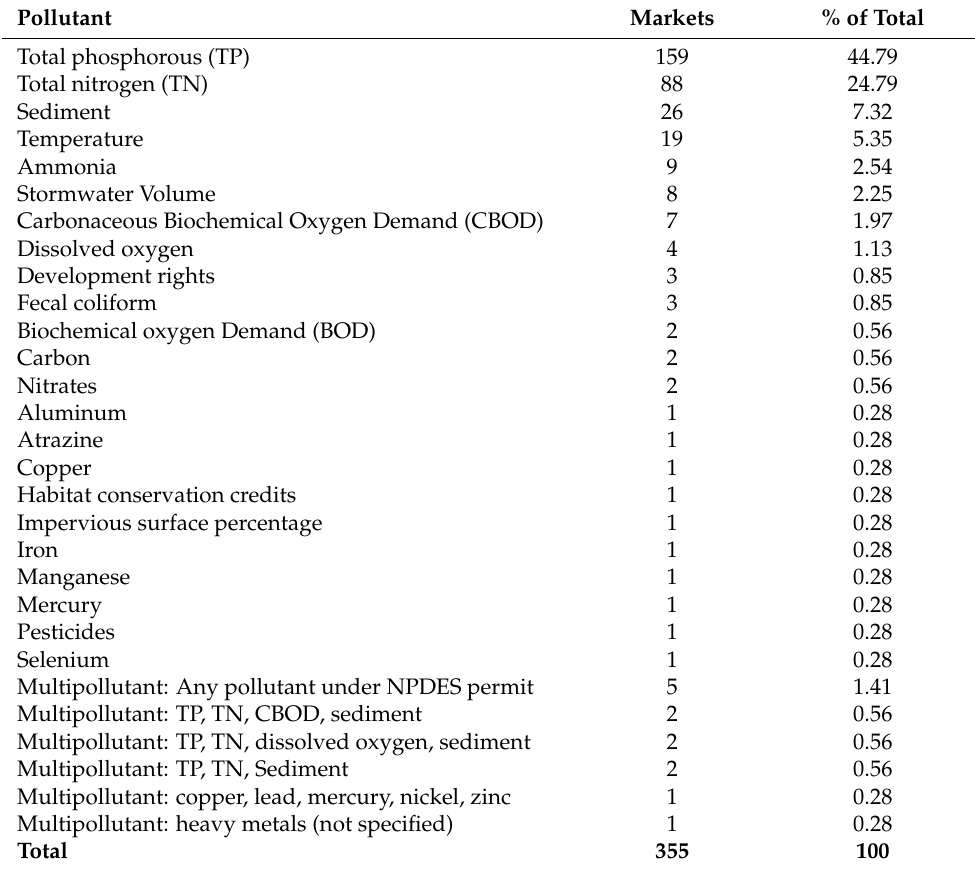
Table A4. Distribution of pollutants traded in WQT markets. NPDES refers to the National Pollution Discharge Elimination